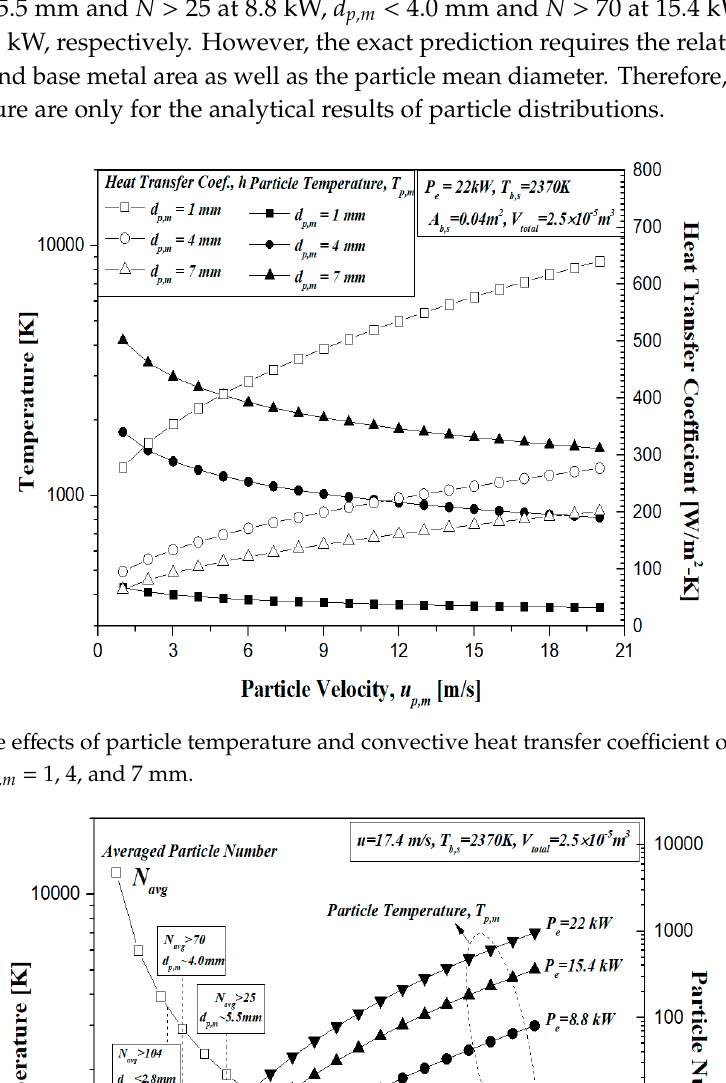
Figure 12. The effects of particle temperature and convective heat transfer coefficient on the particle velocity for dp,m = 1, 4, and 7 mm.